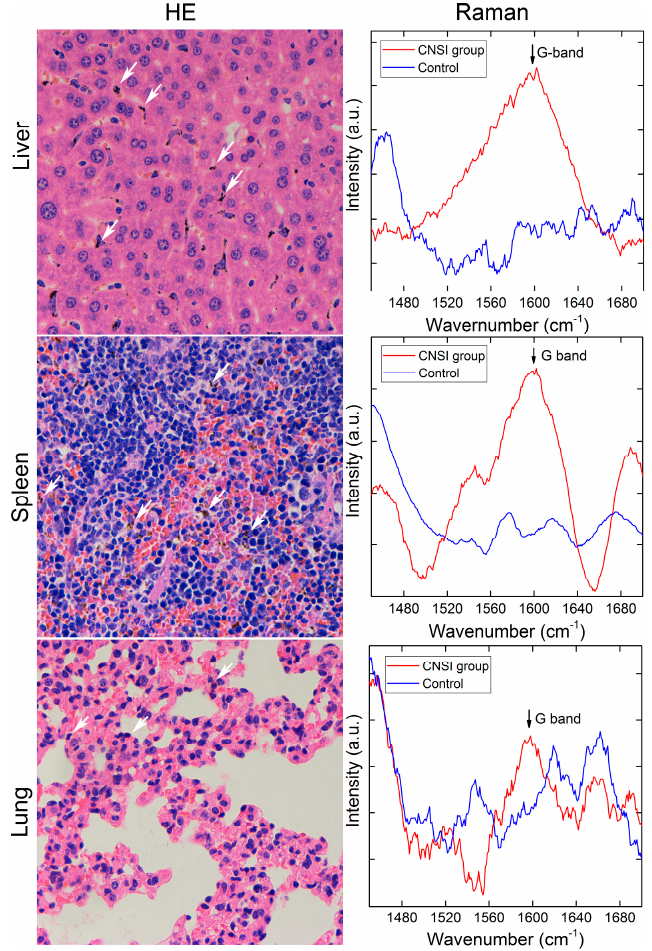
Figure 2. Bioaccumulations of CNSI in reticuloendothelial system (RES) organs, including the liver, spleen, and lungs. The dark aggregates of CNSI are indicated by white arrows (400×). Table 1. Bodyweight increases of the mice exposed to CNSI post intravenous exposure. Data represent means ± SD ( n = 6).